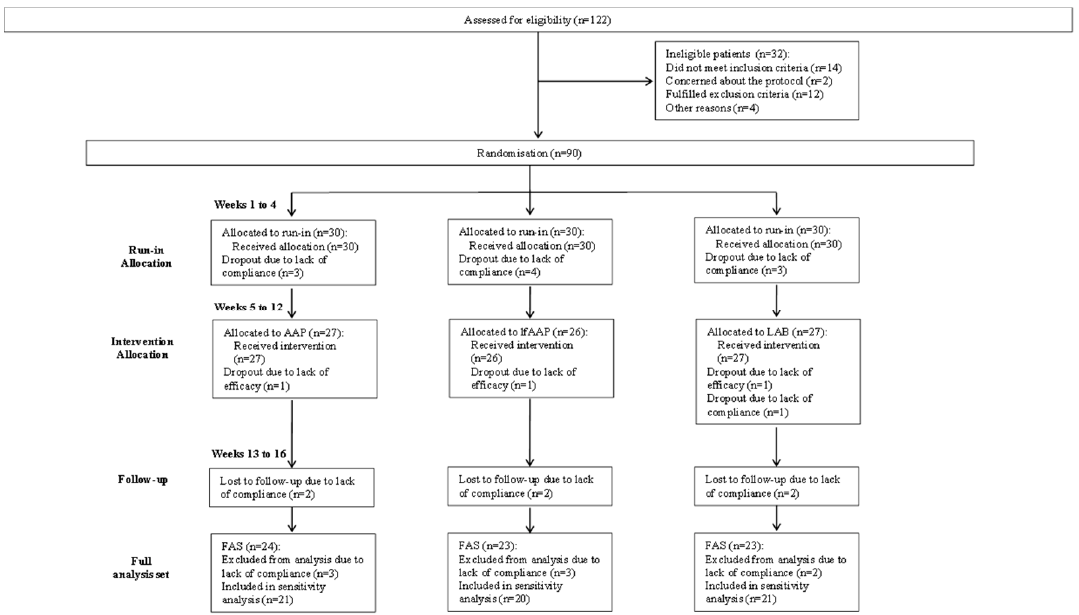
Figure 1. Study flowchart according to the consolidated standards of reporting trials (CONSORT).